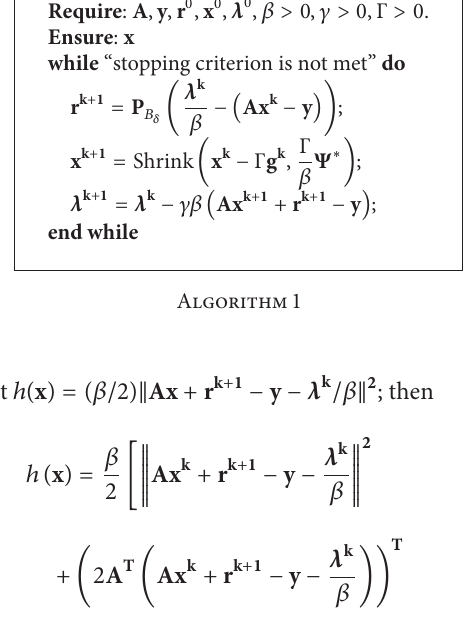
Table 1: Comparisons of different